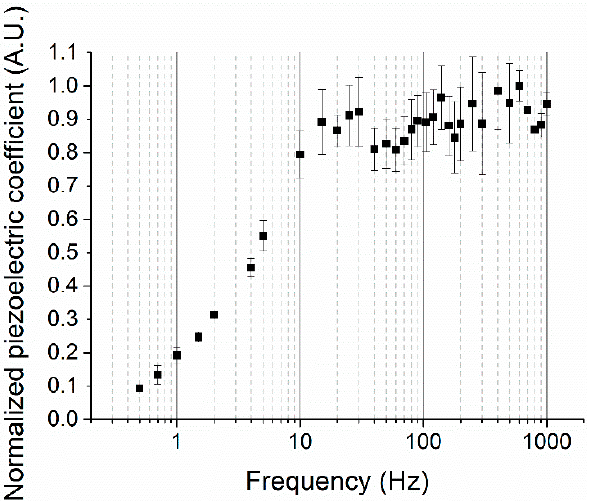
Figure 3. Characterization of the normalized dynamic response of the charged ferroelectret sen- sor in the range of 0.4–1000 Hz for different applied forces (error bars: standard deviation over applied force).